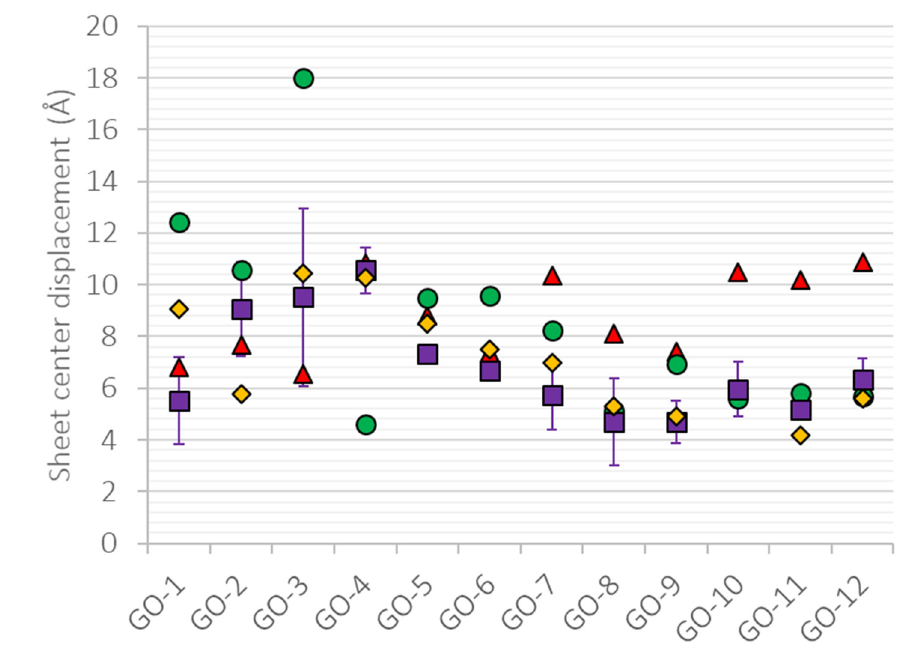
Figure 6. GO sheet three-dimensional displacement: GO in water (red triangles), GO-PAI (purple squares), GO-PVDF (green circles), and GO-PAI-cr (yellow rhombuses).